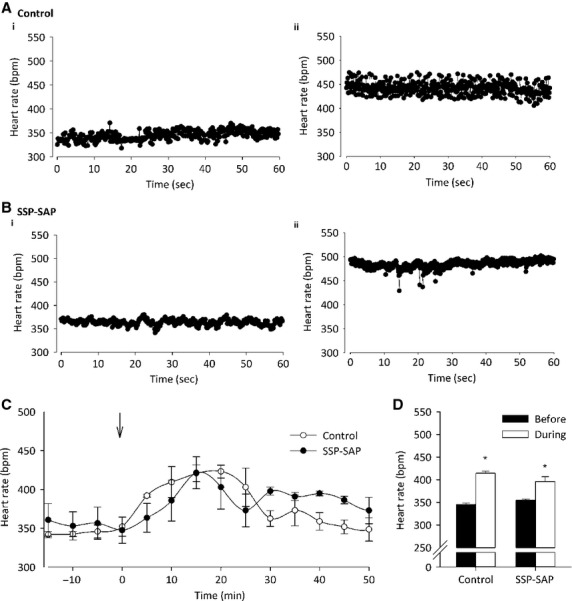
Heart rate response to stress in SAP‐SSP‐lesioned rats. (A) Raw basal heart rate traces of control rats (i) before and (ii) after mild handling stress. (B) Raw basal heart rate traces of SSP‐SAP rats (i) before and (ii) after mild handling stress. (C) Average heart rate per 5 min in both groups of rats. Arrow indicates time of mild handling stress. (D) Heart rate significantly increases both in control rats from 345 ± 2 to 414 ± 5 beats min−1 (n = 3 per group; P < 0.001 by one‐way ANOVA) and in lesioned rats from 354 ± 3 to 396 ± 11 beats min−1 (P < 0.05 by one‐way ANOVA; n = 3 per group). No difference in heart rate response to stress between the two groups was observed.